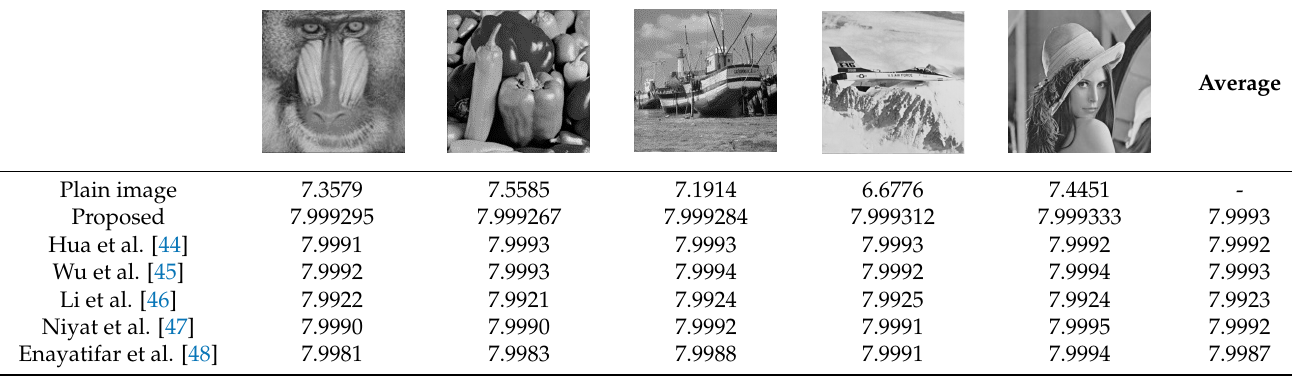
Table 1. Entropy values of images with size 512 × 512 with our algorithm and other encryption algorithms.